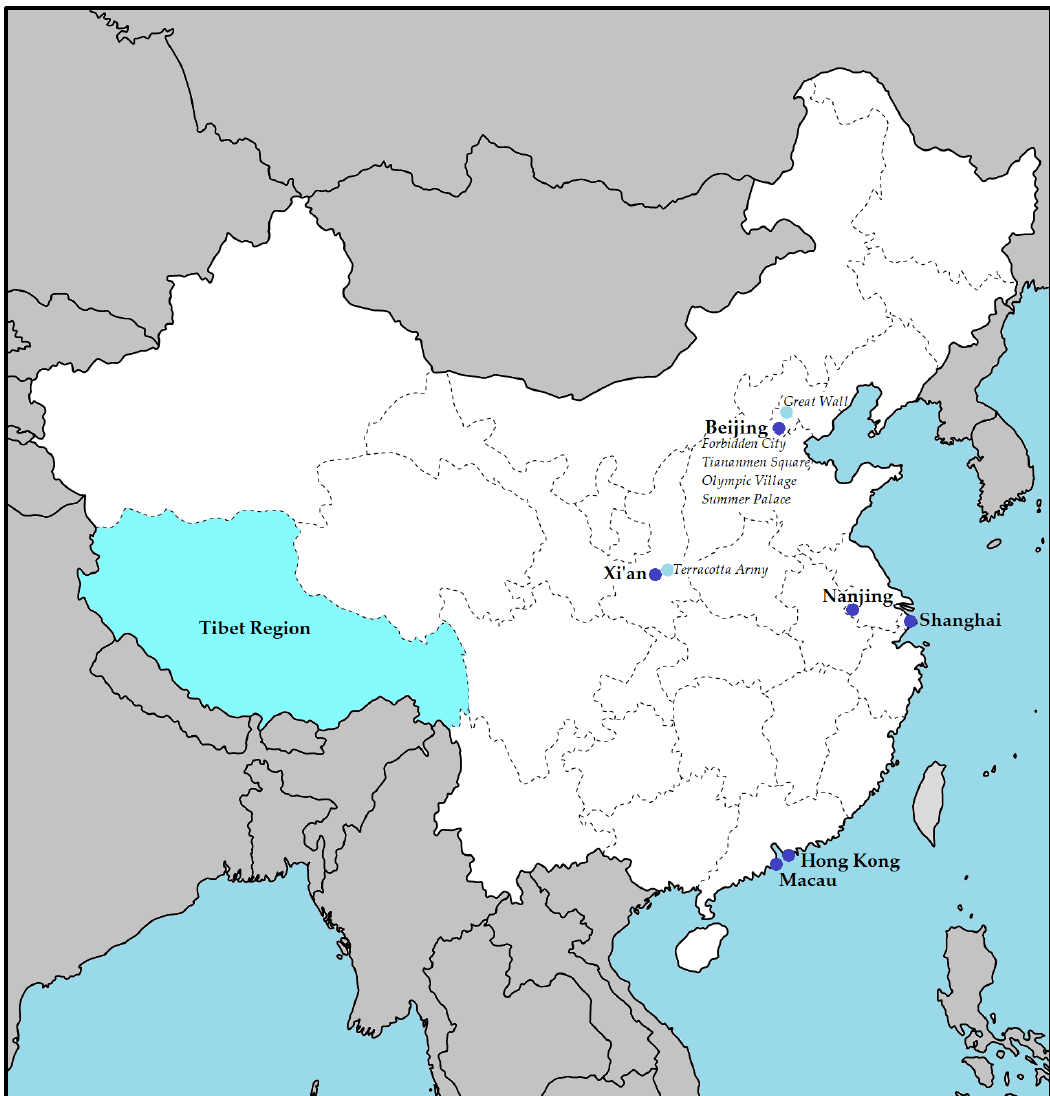
Figure 1. Places in China whose attractions were explicitly